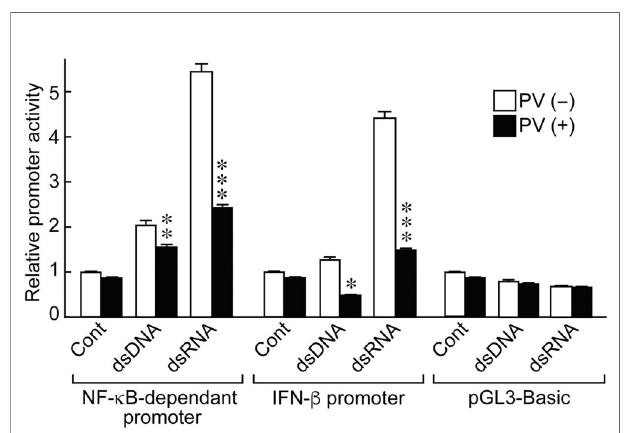
FIGURE 2 | PV suppresses NF- k B-dependent and IFN- b -dependent promoter activation stimulated by dsDNA or dsRNA. FRTL-5 cells were transfected with luciferase chimeric plasmids containing an NF- k B-dependent promoter (p5NF- k B-luc), an IFN- b promoter (pGL3-IFN- b ), or a basic vector (pGL3-basic) for 6 h. Cells were then treated with 350 m g/mL of PV for 24 h, and stimulated with 1 m g of dsDNA or dsRNA for another 24 h. Luciferase reporter gene assays were performed as described in the Materials and Methods. Data are the results from three different experiments, each performed in triplicate, and expressed as the mean ± SD. * p < 0.05, ** p < 0.01 and *** p < 0.001, compared to PV ( − )